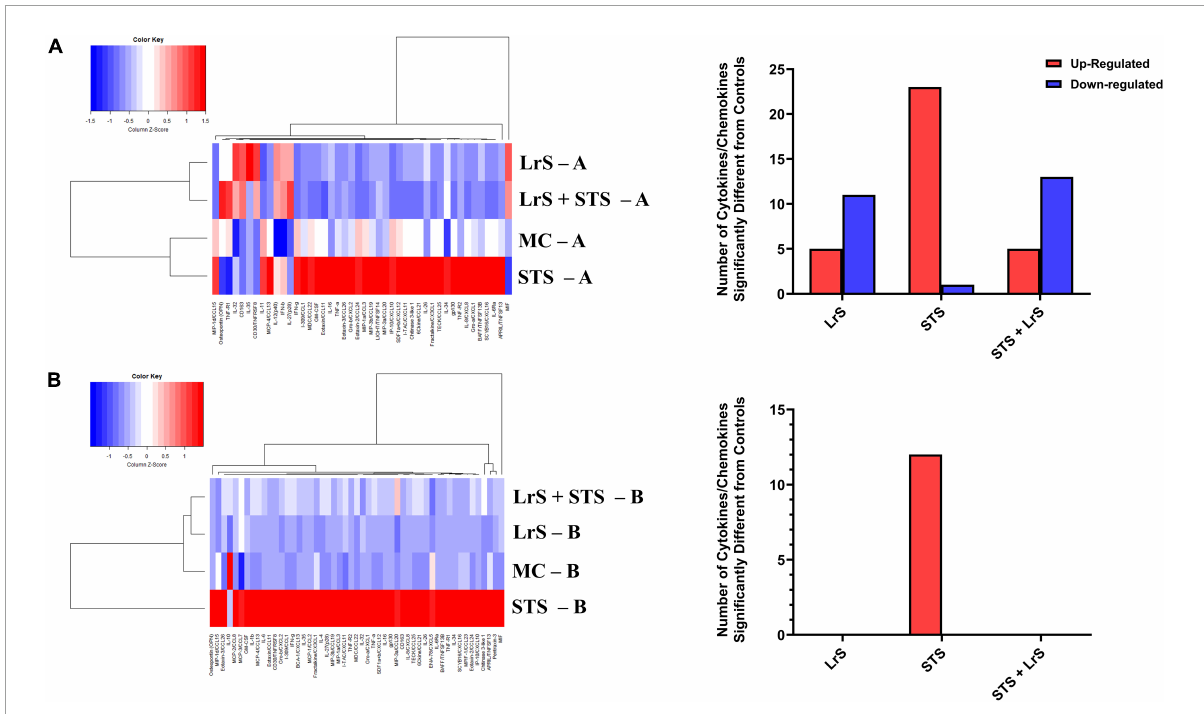
FIGURE1 Two-dimensional hierarchical clustering analysis of cytokine and chemokine production profiles from the (A) apical (A) and (B) basolateral (B) chambers of T84 IEC/THP-1 human monocytes in response to apically delivered LrS, STS, a combination of the LrS and the STS, or medium controls for 24 h. Data shown is the Z-score statistic for each cytokine and chemokine measured ( n =